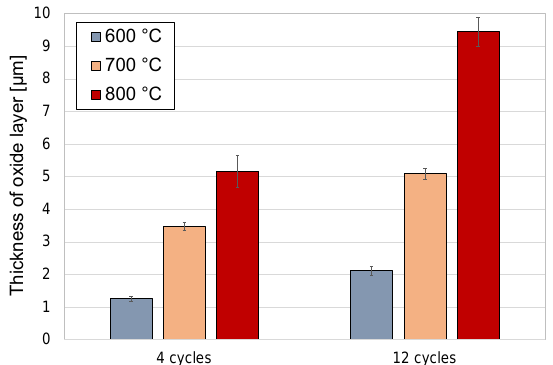
Figure 8. Thickness of oxide scales depending on the oxidation temperature and number of cycles.